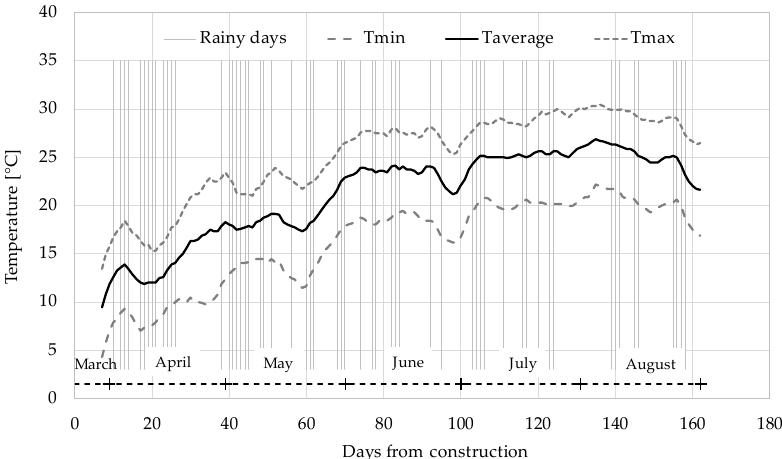
Figure 3. Rainy days (vertical lines) and moving average (period = 7 days) of daily temperatures near the plant.